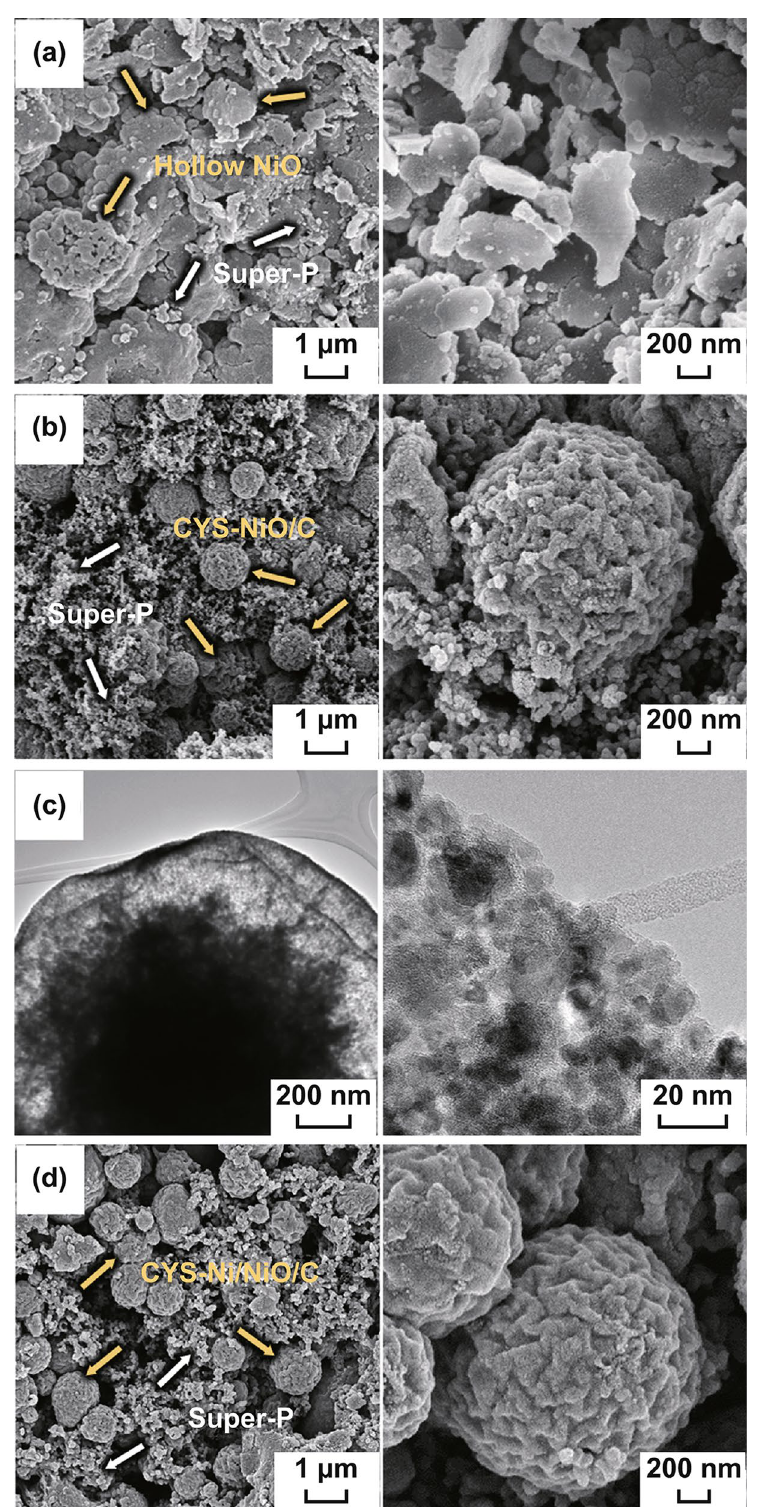
Fig. 9 Morphologies of a hollow NiO, b , c CYS‑NiO/C, and d CYS‑Ni/NiO/C microspheres after the 200th cycles: a , b , d FE‑SEM images and c TEM